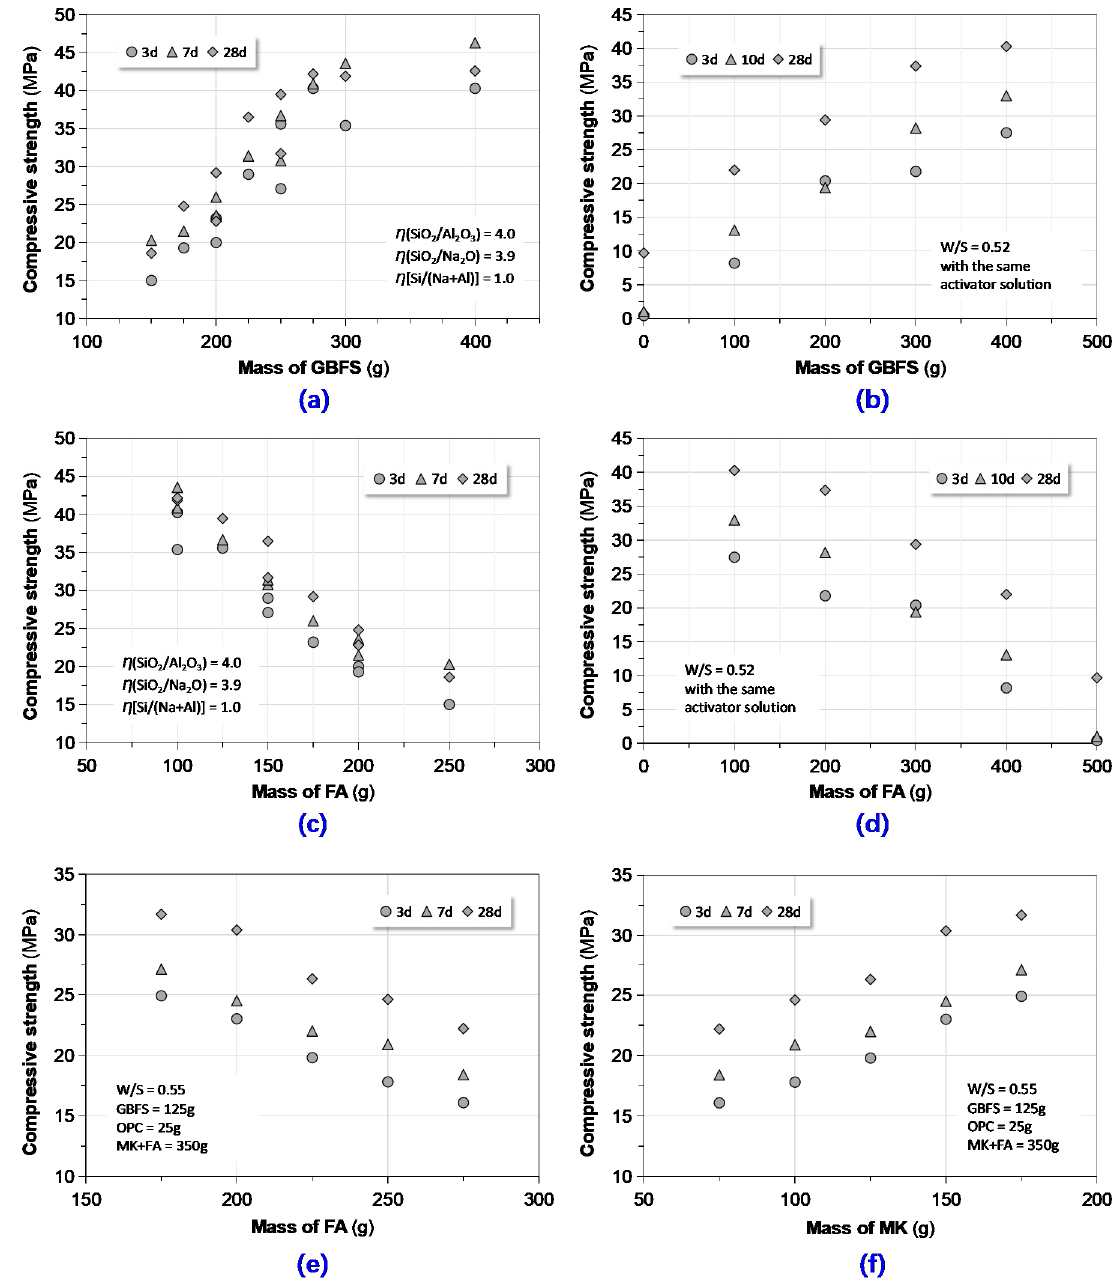
Figure 9. Correlating compressive strength to quadruple precursor composition of GPC: ( a ) and ( b ) compressive strength vs. mass of GBFS; ( c – e ) compressive strength vs. mass of FA; and ( f ) compressive strength vs. mass of MK.